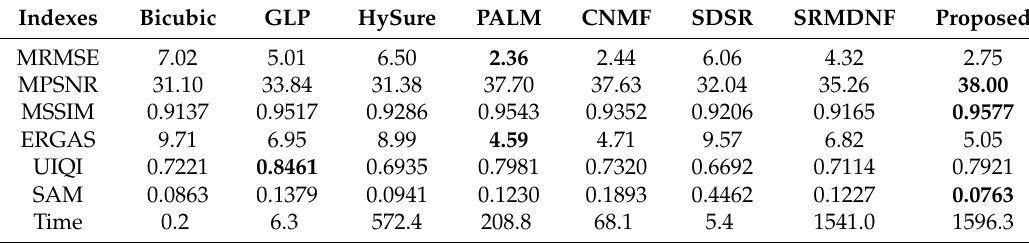
Table 1. Quantitative results on the CAVE dataset with a magnification factor of 3. GLP, Generalized